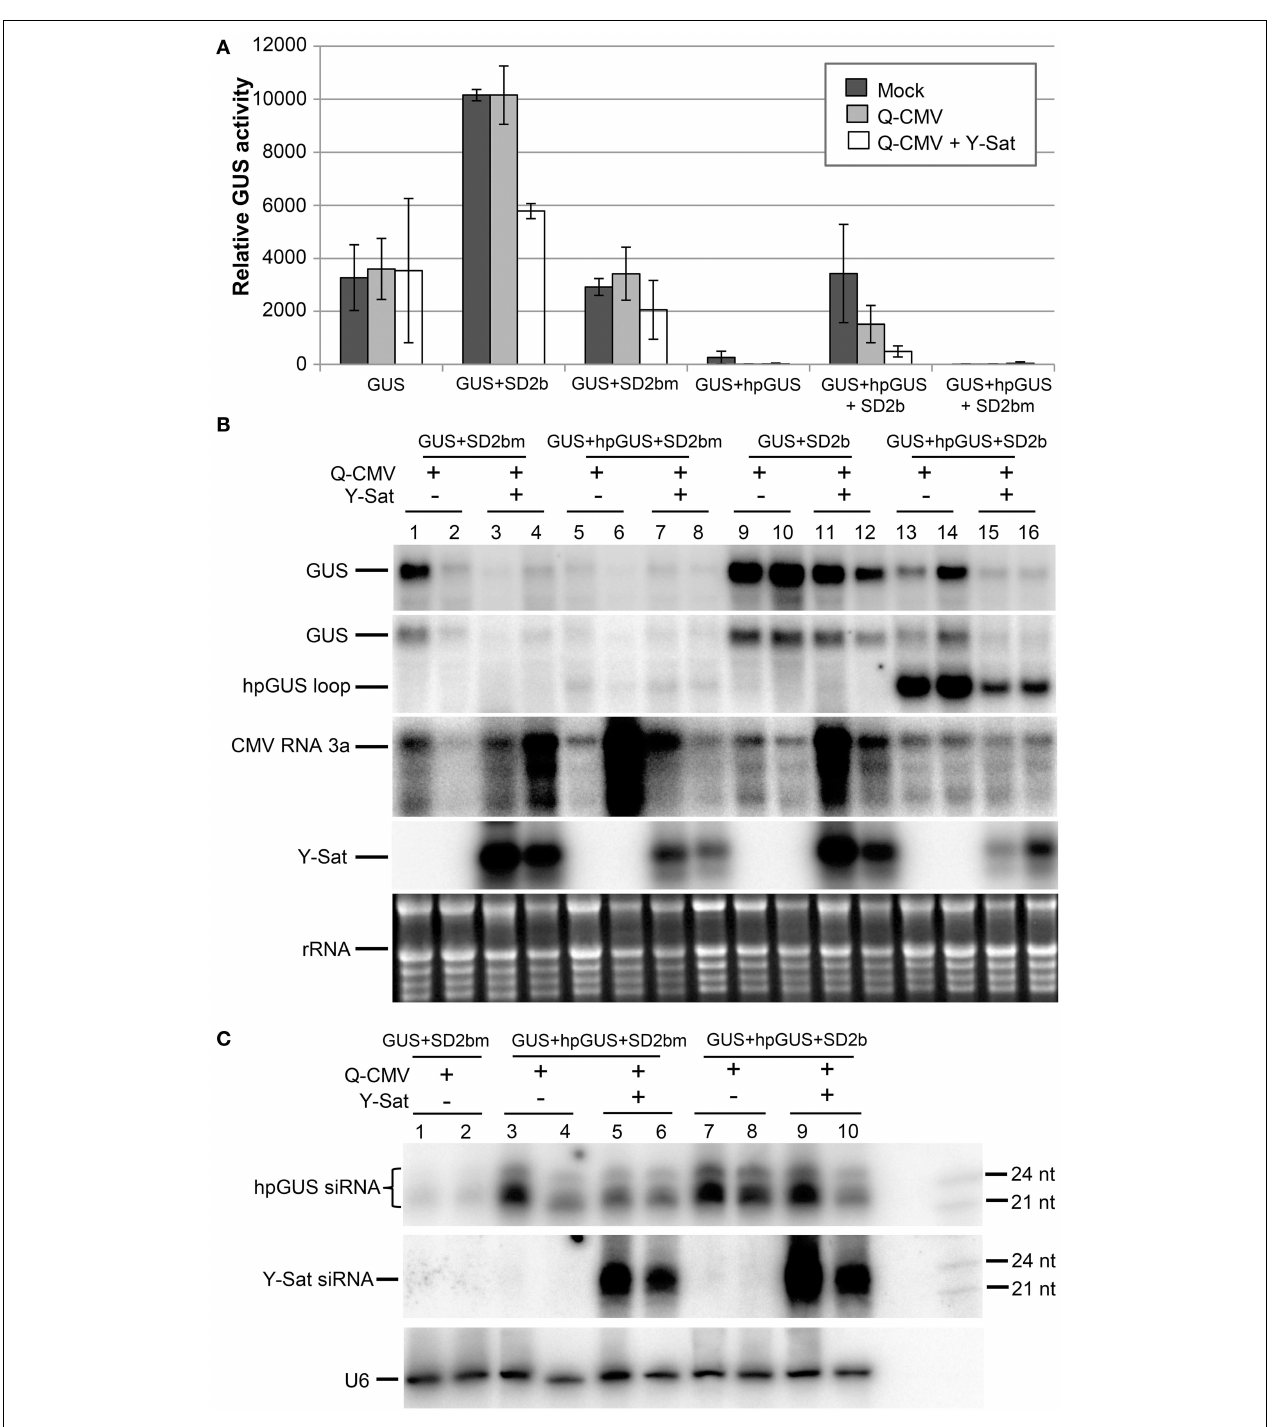
FIGURE 2 | The suppression of hpRNA-induced GUS silencing by agro-infiltrated 2b is released by CMV + Y-Sat infection. (A) MUG assay of GUS expression in Mock (inoculated only with buffer), Q-CMV and Q-CMV + Y-Sat-infected N. benthamiana leaves infiltrated with the constructs indicated. The plants were infiltrated at 11 or 13 days after inoculation. The GUS activity was analyzed at 4 days post agroinfiltration (dpa). (B) Northern blot hybridization analysis of GUS expression in a subset of the samples described in (A) . Ten microgram of total RNA from each sample was